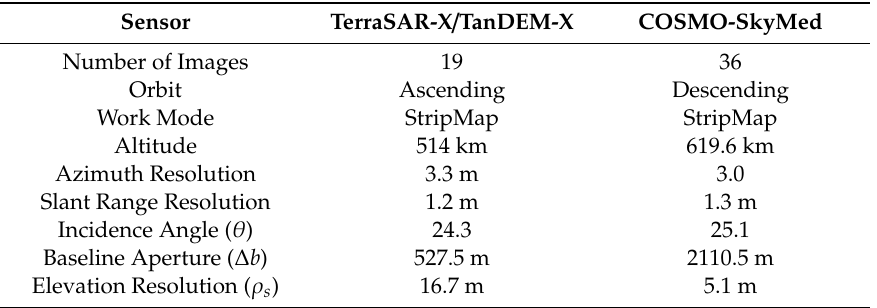
Table 2. Parameters of the data stacks.